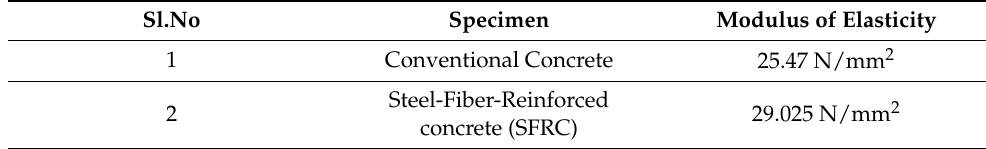
Table 6. Modulus of elasticity of specimens.